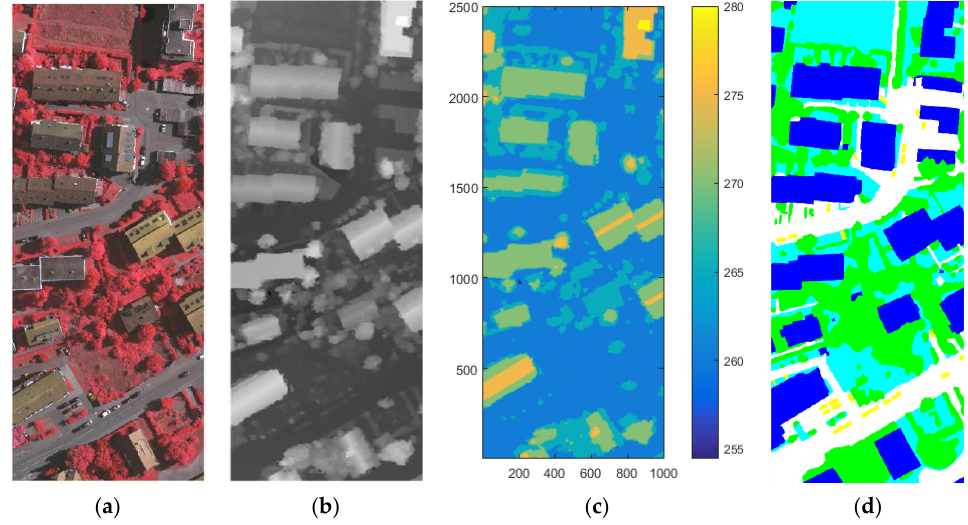
Figure 4. The Vaihingen test area: ( a ) Area 34; ( b ) the ALS DSM data of Area 34; ( c ) the contour of the Area 34; and ( d ) the ground truth map of Area 34.